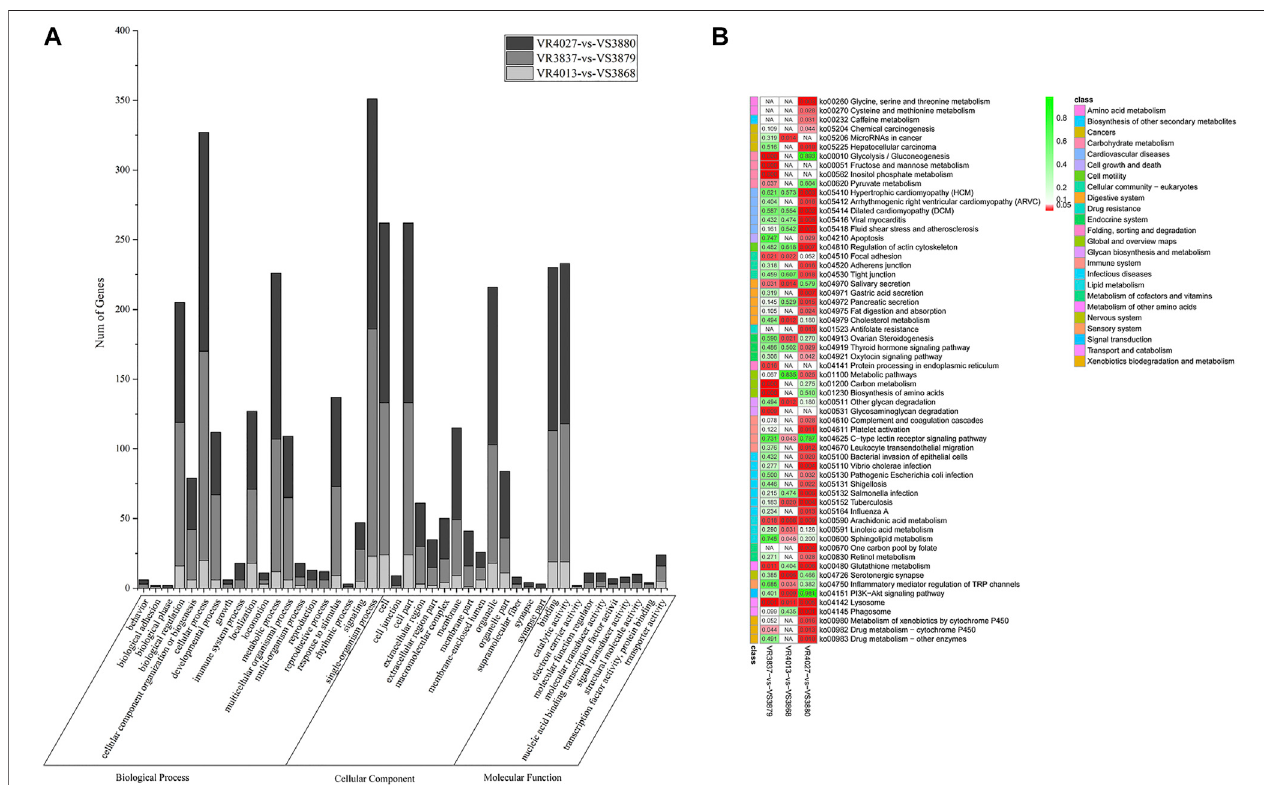
FIGURE 3 | Enrichment analysis of differentially expressed genes (DEGs). (A) Gene Ontology (GO) terms distribution for the DEGs. Light gray represents VR4013- vs.-VR3868. Gray represents VR3837-vs.-VR3879. Dark gray represents VR4027-vs.-VR3880. The x -axis indicates the name of GO subcategories. The y -axis represents the number of genes. (B) Kyoto Encyclopedia of Genes and Genomes (KEGG) pathways enriched about DEGs in VR4013-vs.-VR3868, VR3837-vs.- VR3879, and VR4027-vs.-VR3880.